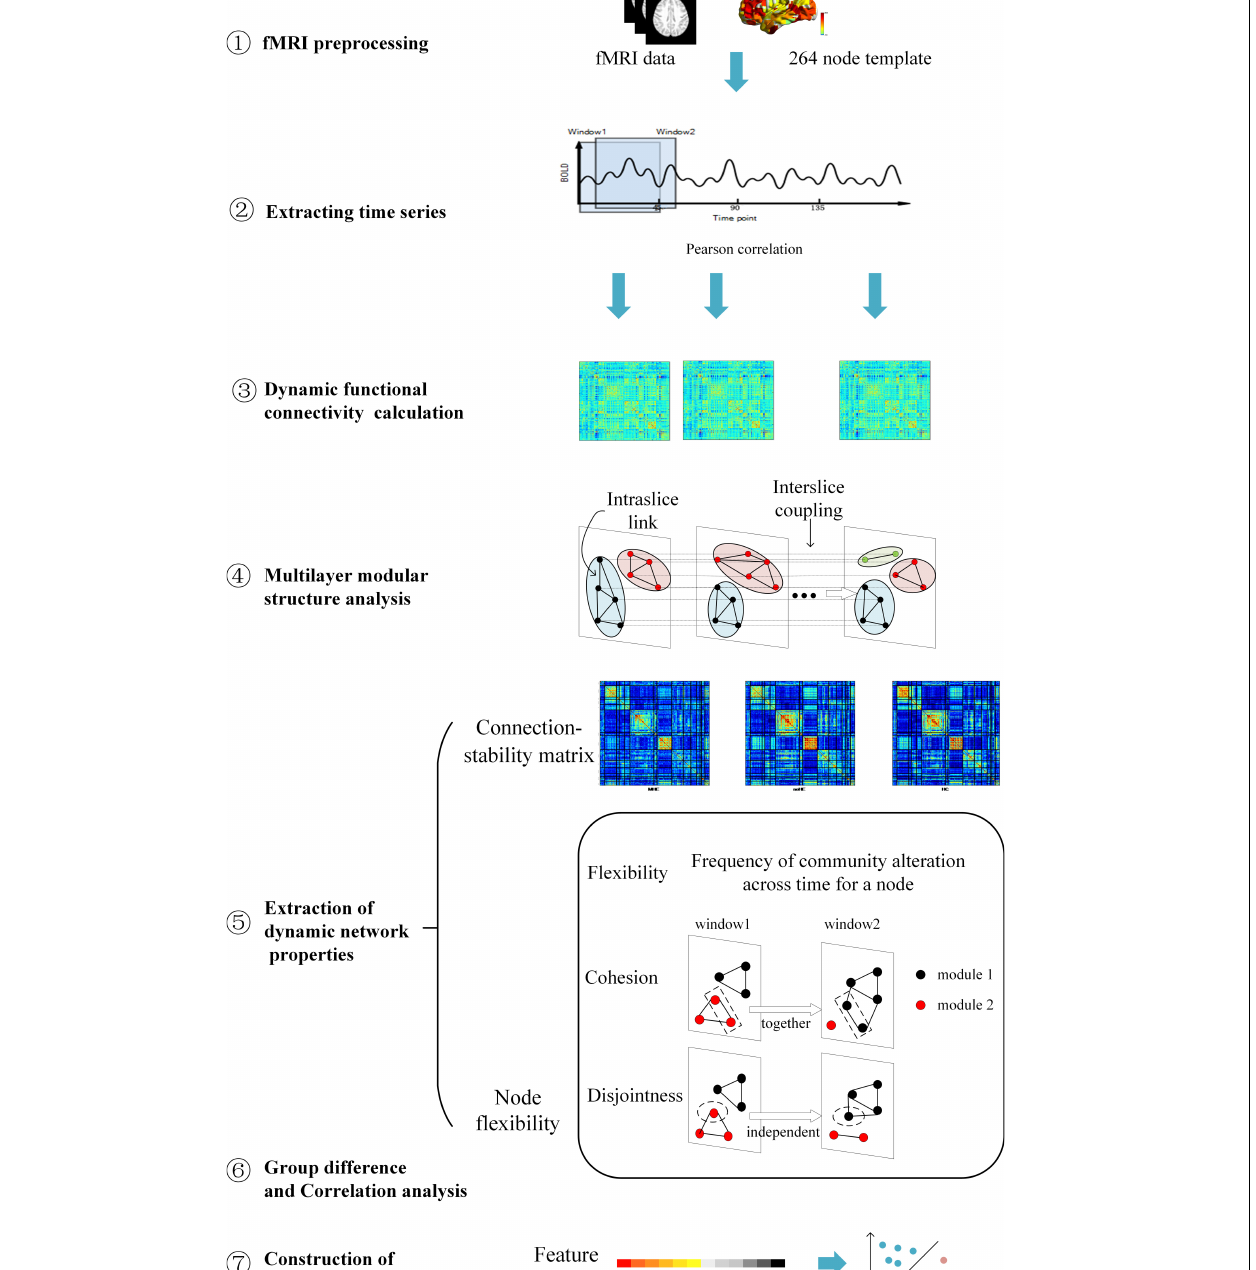
angle (FA) = 90 ◦ , field of view (FOV) = 220 mm × 220 mm, matrix = 96 × 96, slice thickness = 3 mm, slice gap = 0.3 mm, and number of slices = 40. The total scan time of resting-state